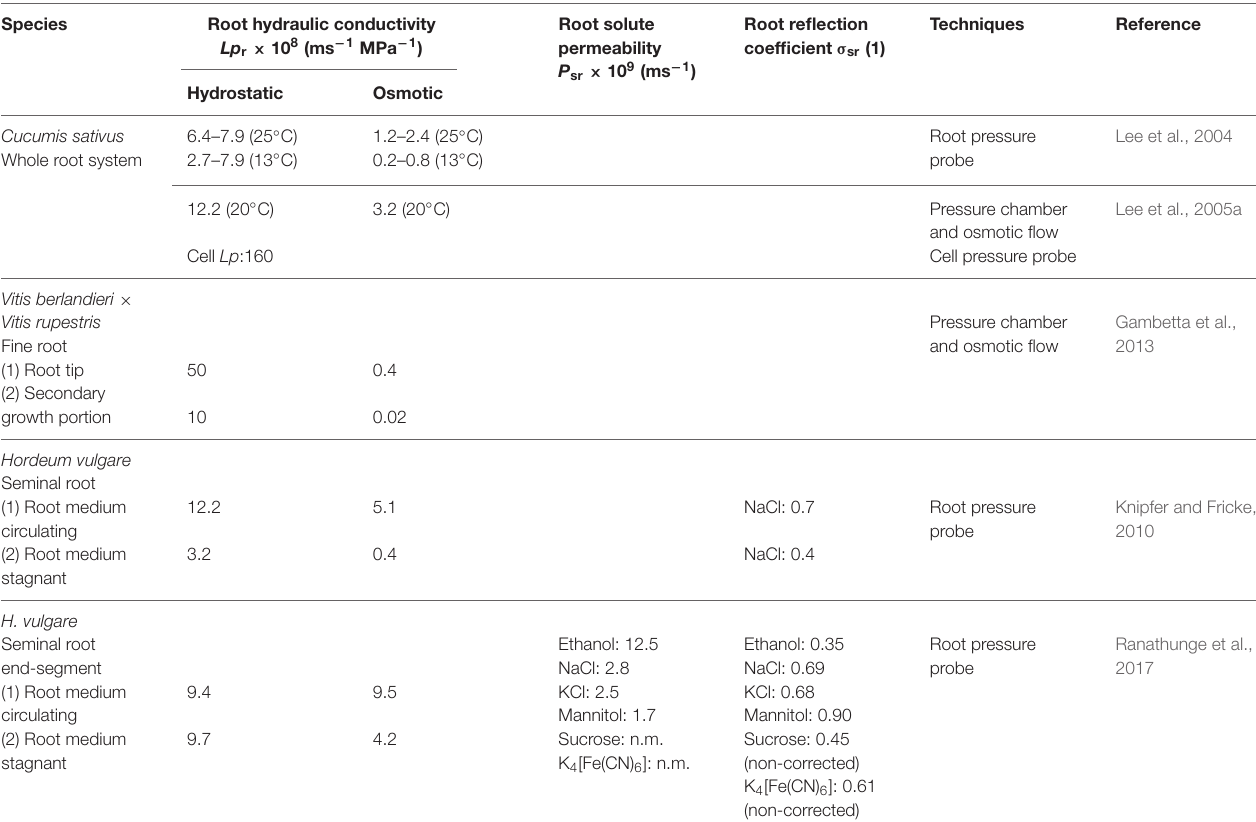
TABLE 1 | Root hydraulic conductivity ( Lp r ), solute permeability ( P sr ), and reflection coefficient ( σ sr ) of different plant species, measured with different techniques.